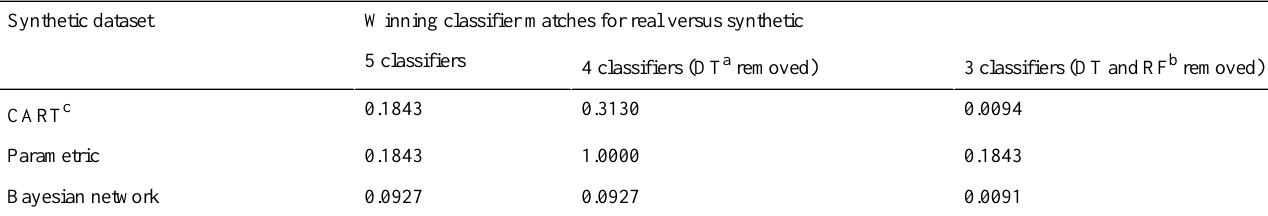
Table 6. Results of chi-square analysis of the difference in matching winning classifiers for models trained on real versus synthetic data. Winning classifier matches for real versus syntheticSynthetic